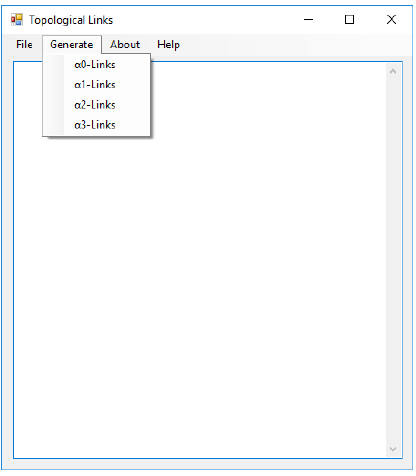
Figure 4. Extracted geometrical properties of Dataset B The geometrical properties of the building in 0D, 1D, and 2D are used to generate the topological links which in turn can traverse through the building and topologically represent the building. A program was developed using Visual Studio 2010 to generate the topological links for the buildings. The program interface is shown in Figure 5.